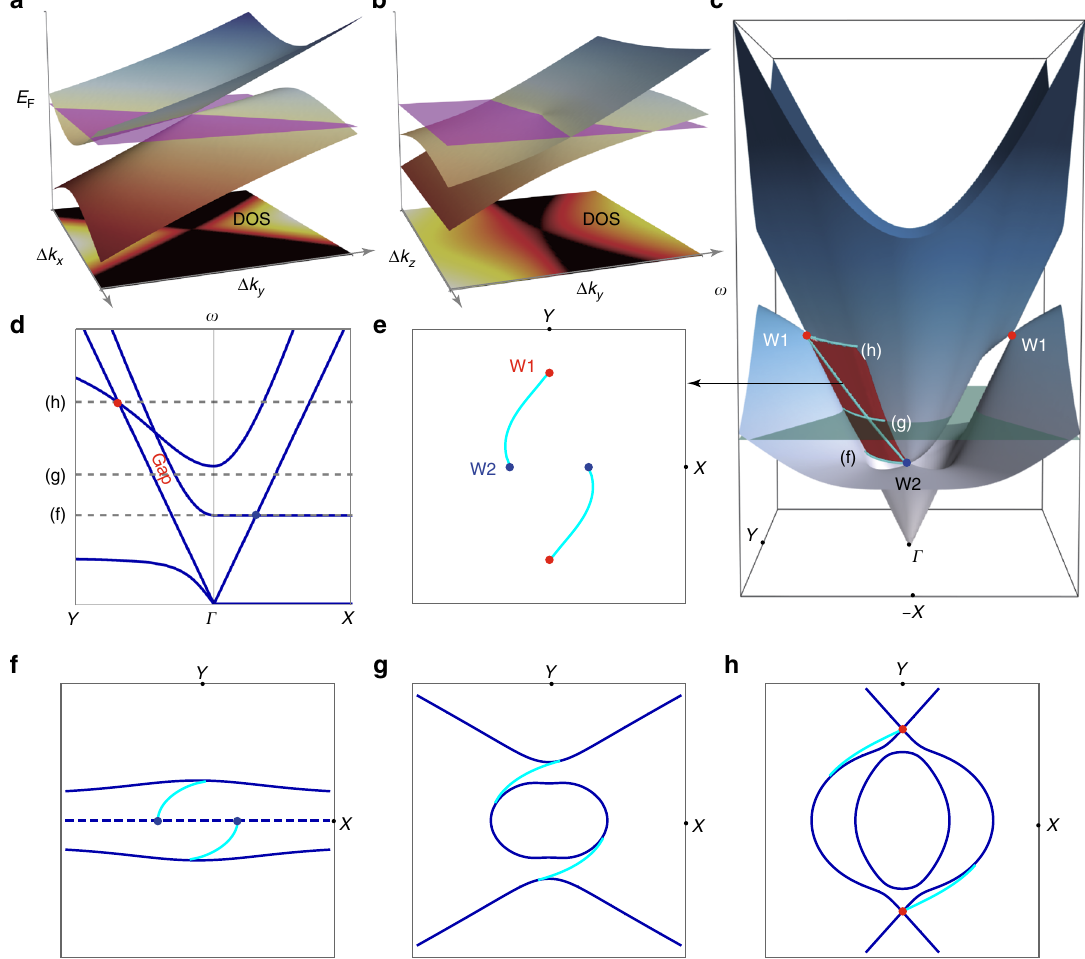
Fig. 1 Bulk and surface states in an effective-medium model of chiral hyperbolic metamaterials. Schematic view of energy dispersion near a type-II Weyl point for the chiral hyperbolic metamaterials (CHM) with respect to a x – y and b y – z momentum space. Bottom planes show momentum resolved density of states (DOS) at the ‘ Fermi energy ’ E F indicated by the purple plane . c Effectively modeled band structures of bulk (7th and 8th bands) and surface states for the CHM. Red dots (W1) indicate one pair of type-II Weyl points. Blue dots (W2) (one is hidden) are their chiral partners. One surface state between two topological partners is indicated by the red surface , on which the cyan lines highlight surface-state arcs. To show the gap, the other surface state is not plotted; it can be obtained after time-reversal operation of the present one. d Bulk bands along Y (0, − 3,0) – Γ (0,0,0) – X (3,0,0). e Surface band structure on a varying-frequency k x – k y map. The arc ( k y > 0) is constructed from intersection between the surface state ( red surface in c ) and a plane with constraints: ω is proportional to k y and k x is arbitrary. f – h , show three equi-frequency contours ( EFCs ) containing both bulk and surface states on the k x – k y plane. Their corresponding frequencies are indicated in c with cyan lines and in d with dashed lines , respectively. In f , the dashed line indicates the fl at band ( Γ – X ) in d . Here, ε 0 = μ 0 = c = 1, ω , k x , and k y are normalized with respect of ω p (at k y = 0), which is the plasma